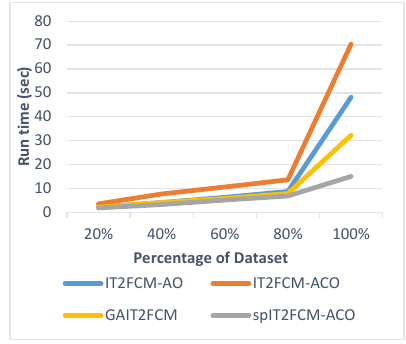
Figure 7. Analysis of run time for different percentages of forest dataset.